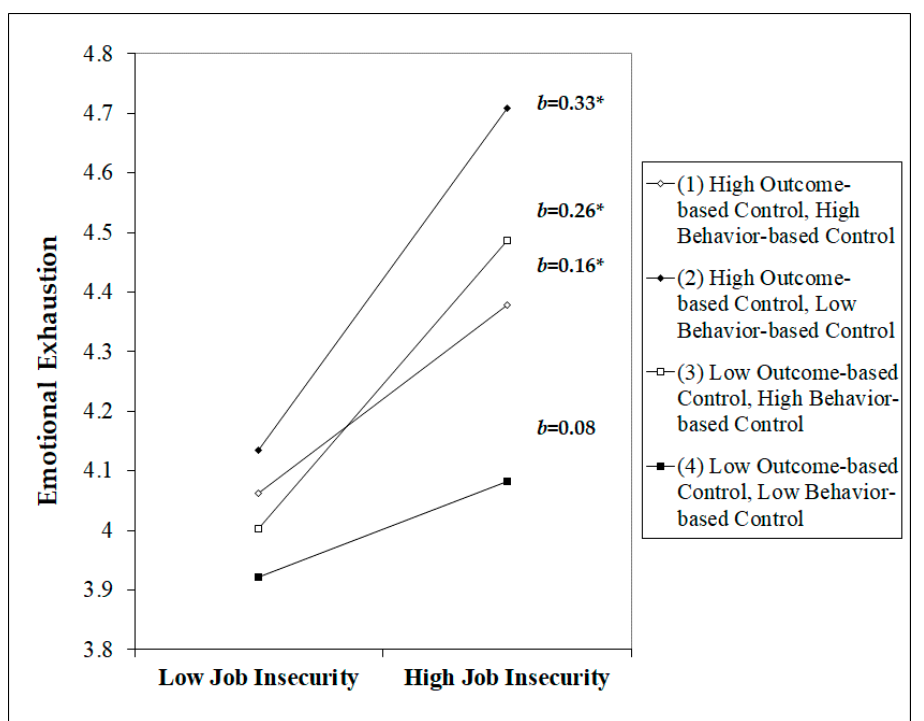
Figure 2. Interaction effect of outcome-based control and behavior-based control on the relationship between job insecurity and emotional exhaustion. Note: * p < 0.05. b = unstandardized coefficient. Hypothesis 3 predicts a three-way interaction between job insecurity, outcome-based control, and behavior-based control a ff ecting insomnia symptoms through emotional exhaustion, such